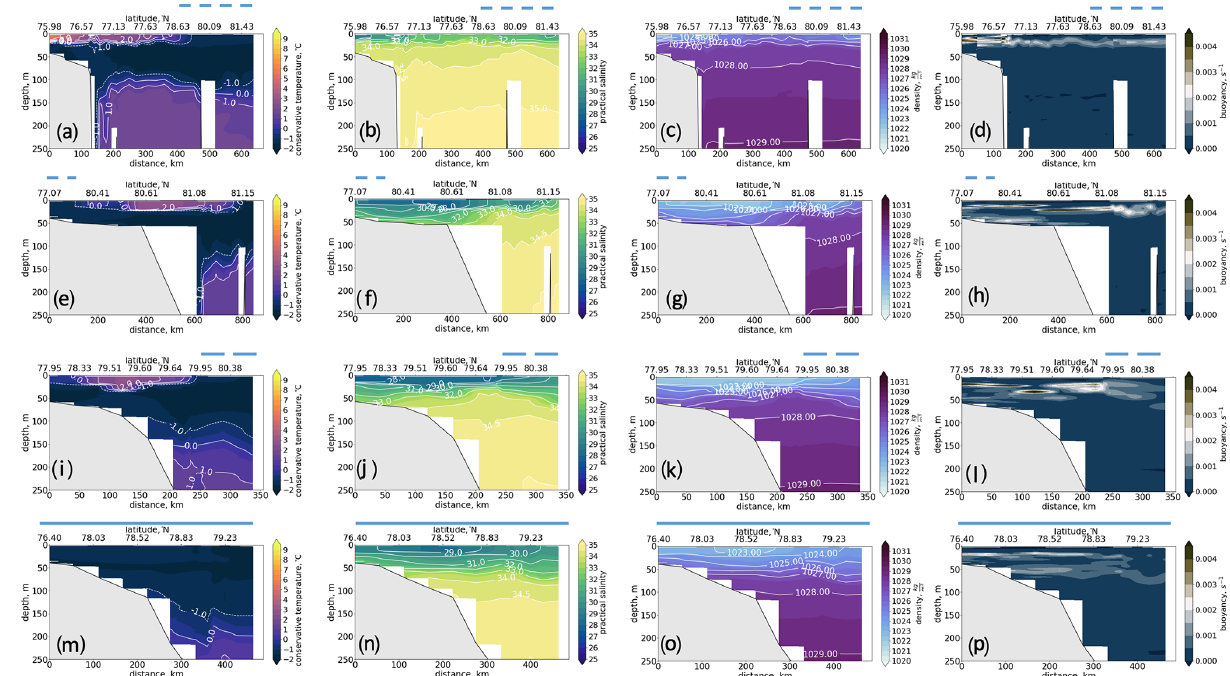
Figure 13. Conservative temperature (left, first column), practical salinity (second column), density (third column), and Brünt–Vaisälä frequency (right, last column) in the upper 250m along oceanographic transect 5 (a–d) , transect 6 (e–h) , transect 8 (i–l) , and transect 7 (m–p) . See Fig. 1 for the section positions. The 0km point is always placed at the southern point of each transect. The dashed blue line indicates the MIZ for transects 5, 6, and 8 (the rest is ice-free area); the full line indicated that transect 7 was done under the ice.